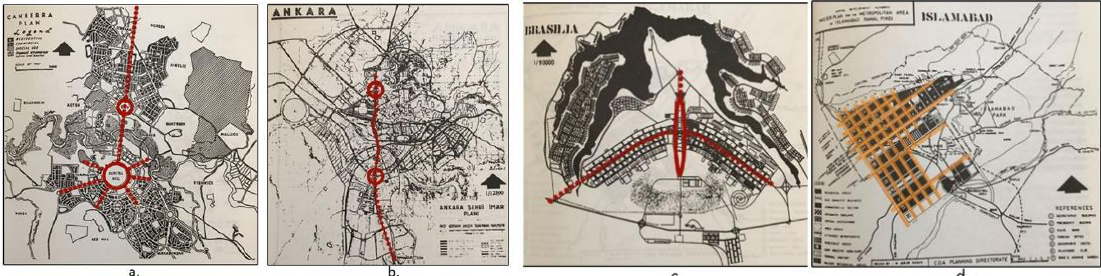
Figure 1 Plans of four sample capital cities (a. Canberra, b. Ankara, c. Brasilia, d. Islamabad; schematised by the author from Tankut,